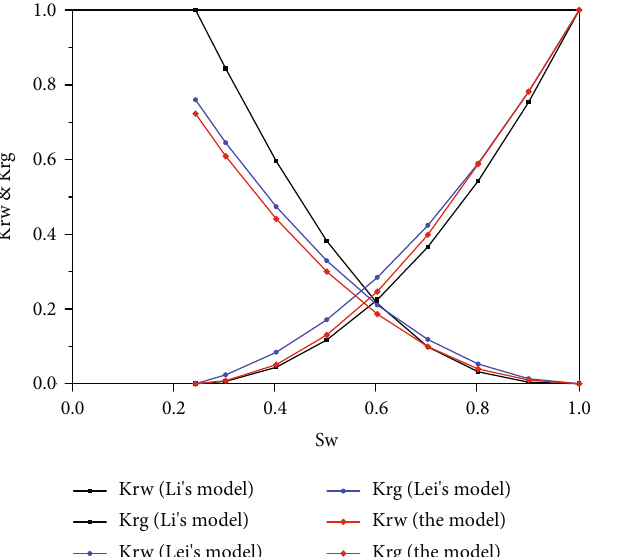
Figure 4: Relationship curve between irreducible water saturation and e ff ective stress under di ff erent elastic